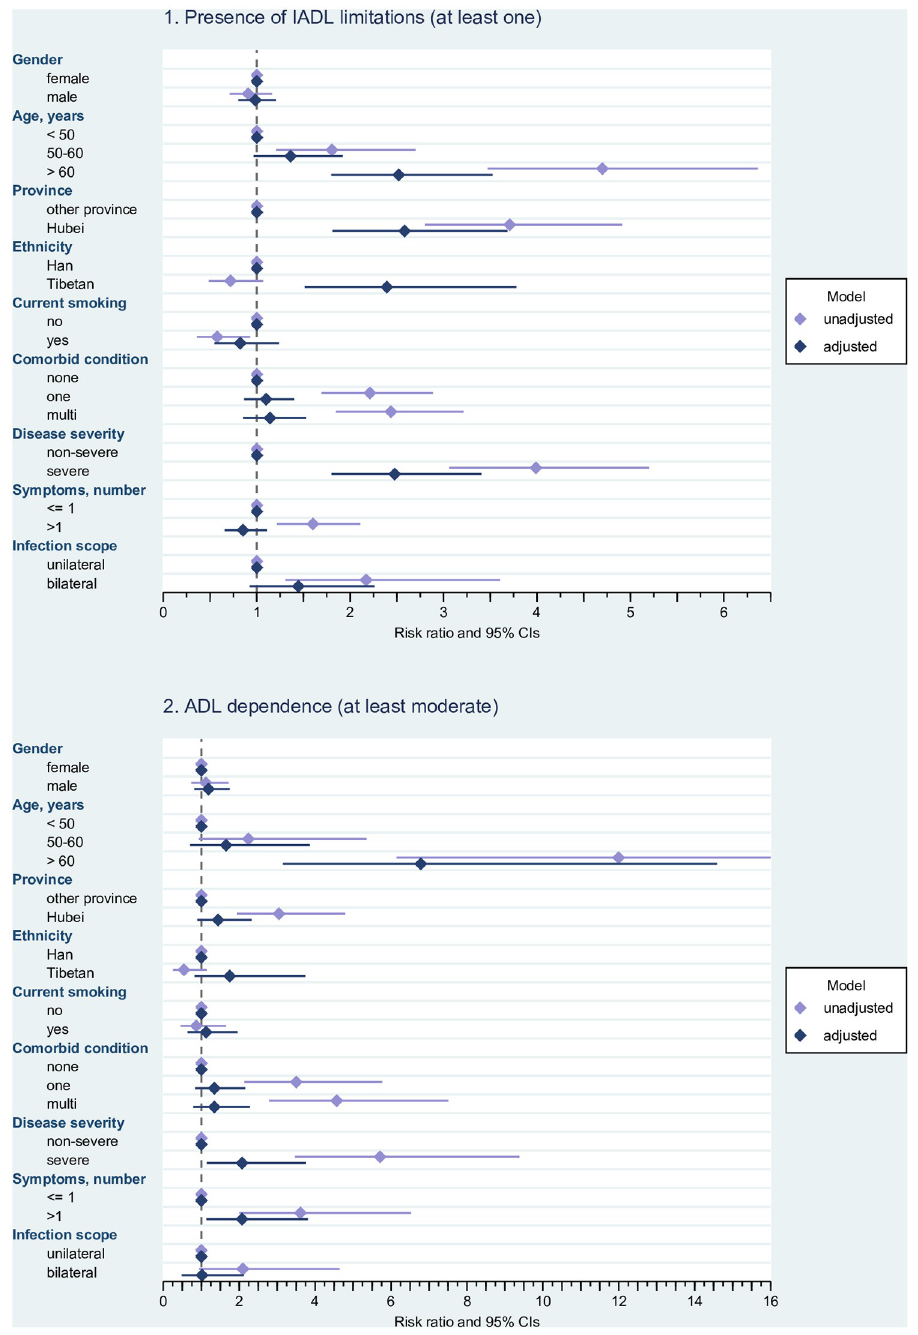
Fig 1. Disability (IADL limitations and ADL dependence) in relation to potential risk factors. Risk ratios and 95% confidence intervals. Estimated from log-linear Poisson regression with robust standard errors; unadjusted risk ratios are estimated from univariable models for the effect of the respective predictor on the outcome, adjusted risk ratios are estimated from a multivariable model containing all potential risk factors. IADL = Instrumental Activities of Daily Living. ADL = Activities of Daily Living.CI = confidence interval. Note: In the case of ADL dependence, the upper limit of the confidence interval for the unadjusted estimate of age > 60 years has been truncated for better readability of the other effects (see S1-S3 Tables in S1 Appendix for details). Adjusted model and unadjusted model for age have been estimated for 431 cases (because of one missing date of birth).